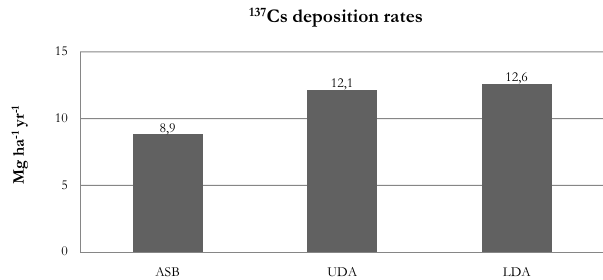
Fig. 3. Mean depth distribution of 137 Cs (Bqm − 2 ) in the soil of reference site. The sum of the average areal activity density reported for each 3cm layer is the 137 Cs baseline level.